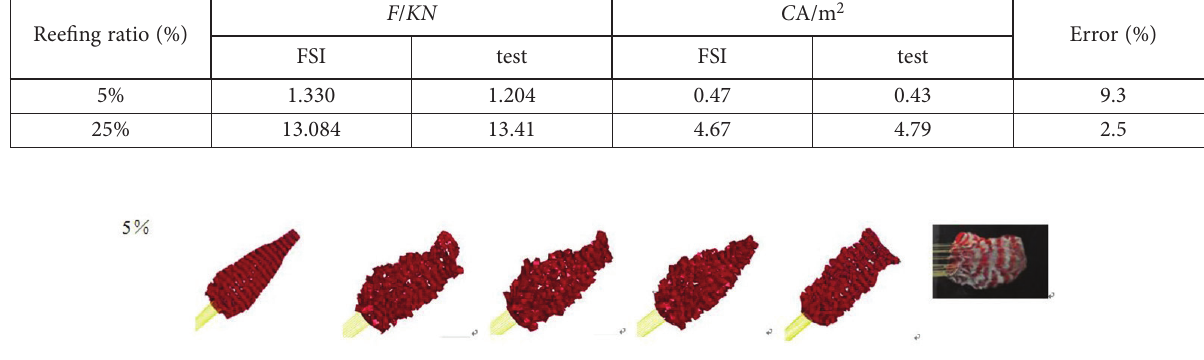
Table 2. Comparison of the numerical and wind tunnel results Reefing ratio (%)